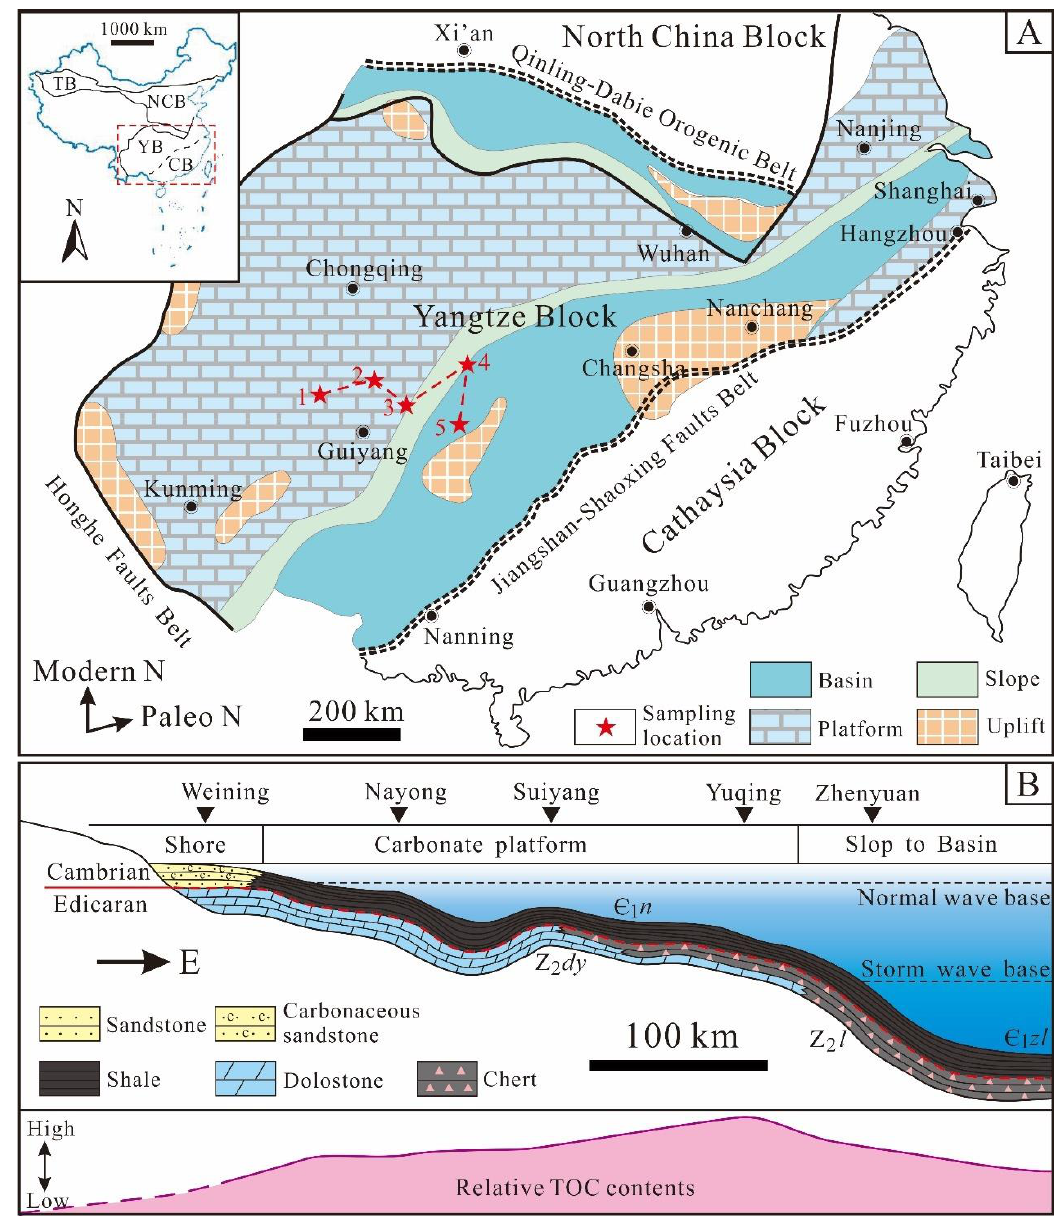
Figure 1. ( A ) Paleoenvironment reconstruction of the Yangtze Block during the Ediacaran – Cambrian transition stage illustrating the geological setting of the study area (modified from [32,38]). The red stars are the sample locations. 1 — Yankong section, 2 — Songlin section, 3 — Yonghe stars are the sample locations. 1—Yankong section, 2—Songlin section, 3—Yonghe section, 4—well section, 4 — well ZK102, and 5 — well ZK205. ( B ) Sketch showing the sedimentary environment and ZK102, and 5—well ZK205. ( B ) Sketch showing the sedimentary environment and the relative TOC the relative TOC contents of the Lower Cambrian black shale, Guizhou Province (modified from contents of the Lower Cambrian black shale, Guizhou Province (modified from [39], and the TOC [39], and the TOC data are from [7]). Z 2 dy — the Ediacaran Dengying Formation, Z 2 l — the Ediacaran data are from [7]). Z 2 dy —the Ediacaran Dengying Formation, Z 2 l —the Ediacaran Laobao Laobao Formation, ∈ 1 n — the Cambrian Niutitang Formation, and ∈ 1 zl — the Cambrian Zhalagou Formation.